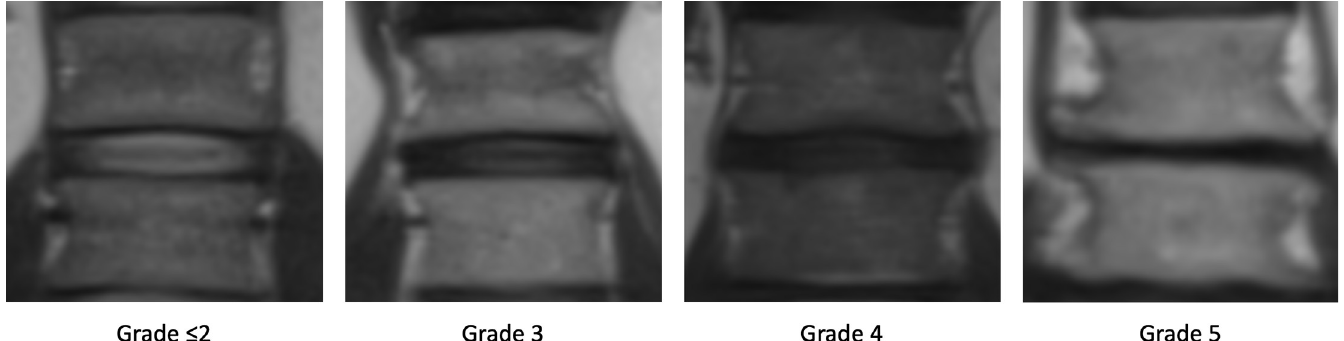
Fig 3. Adapted Pfirrmann grading for intervertebral disc degeneration L1/2 on a T2-HASTE sequence.